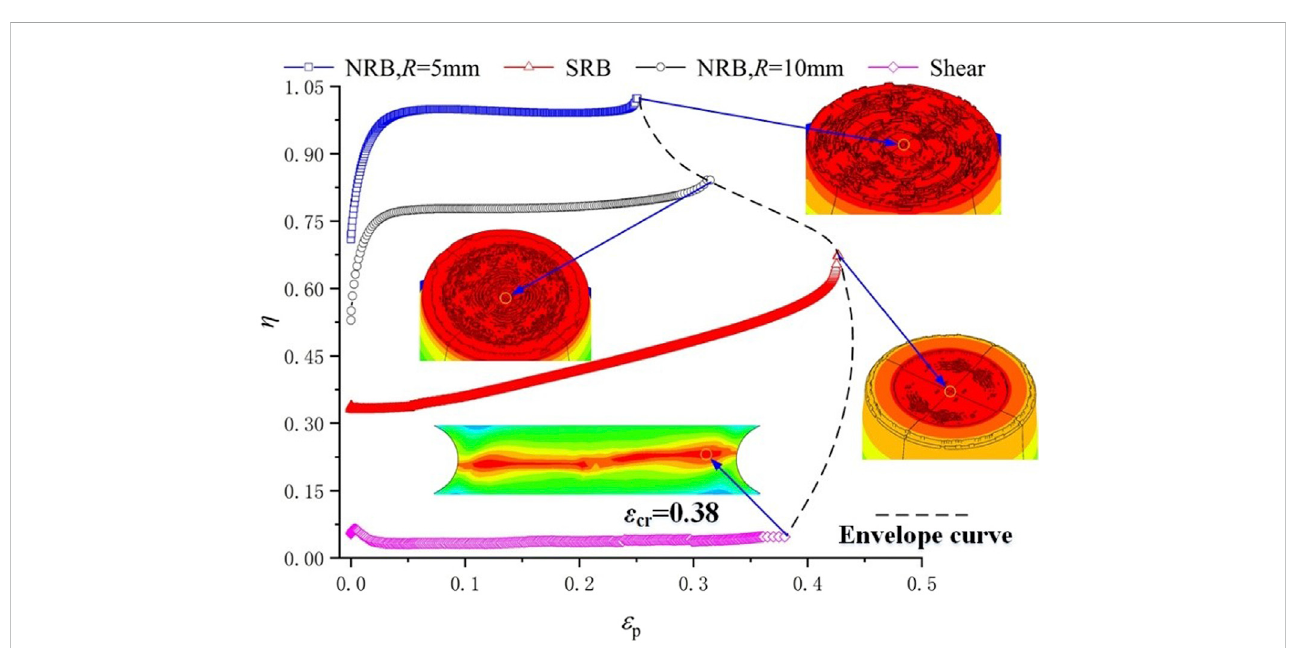
FIGURE 7 Equivalent plastic strain versus stress triaxiality for the critical point of each